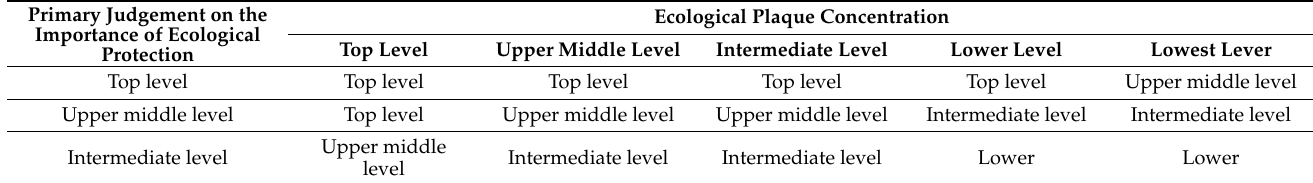
Table 2. Discriminant matrix of ecological protection